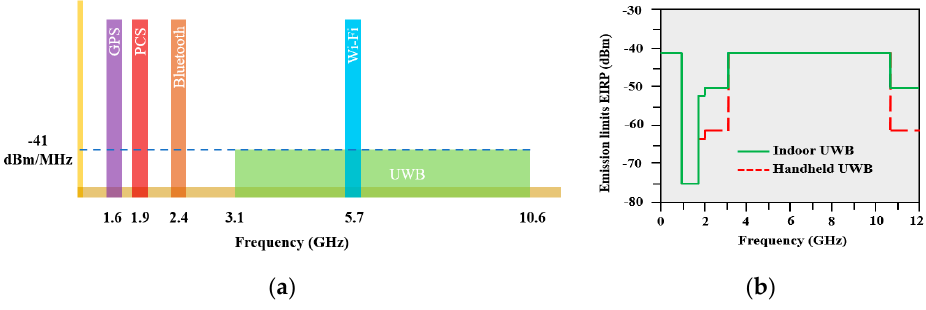
Figure 1. ( a ) The signal spectrum and ( b ) mask of an Ultra-Wideband (UWB) system.